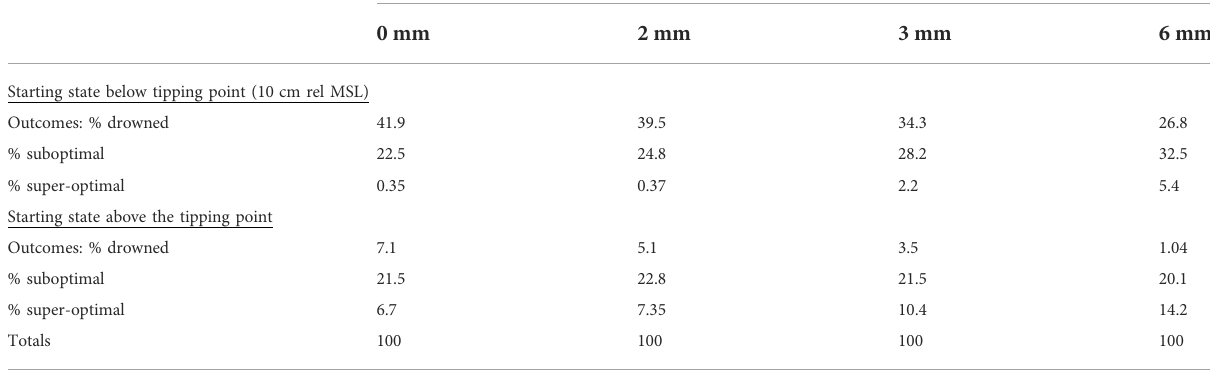
TABLE 3 Percentages of simulation results culminating in states of drowned, suboptimal, and super-optimal elevations following 100-year simulations as functions of episodic disturbance regime and starting state. The percentage outcomes are grouped according to simulated amounts of sediment deposited triennially and generated from model permutations of starting elevation in 5 cm increments and CSLR (from 40 to 200 cm per 100 years) in 10 cm increments. Outcomes (%) by disturbance regime (mm sediment deposited triennially †